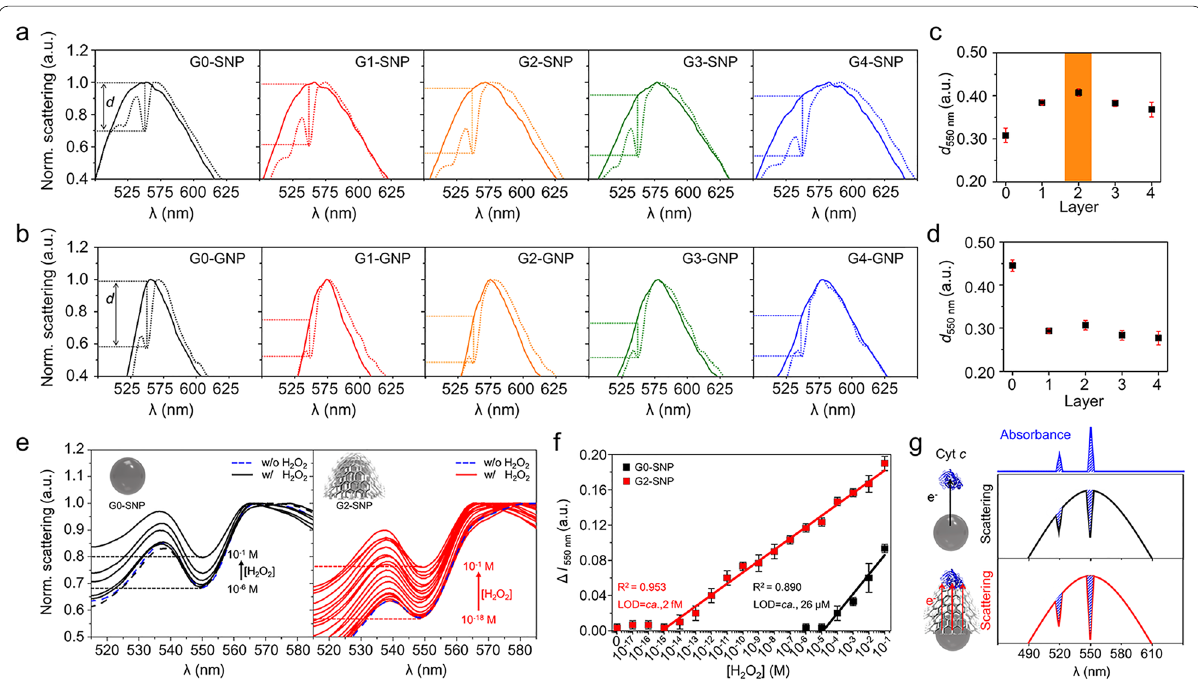
Fig. 4 Optimization of the plasmonic NP-graphene interface for Cyt c -mediated PRET and ROS detection. a , b Cyt c -mediated PRET signals measured using SNP ( a ) and GNP ( b ) with increasing number of graphene layers. Solid lines and dotted lines indicate the probe spectra in the absence and presence of Cyt c , respectively. c , d Plots showing the change in depth of the quenching dip at 550 nm measured using SNP ( c ) and GNP ( d ) with increasing number of graphene layers. e H 2 O 2 concentration-dependent changes in the spectral quenching dip of the SNP probe (left, G0-SNP) and SNP probe covered with two layers of graphene (right, G2-SNP). f Calibration curves for H 2 O 2 obtained with G2-SNP (red) and G0-SNP (black). g Illustration showing the relationship between electron movement through the interface and the resulting PRET signal